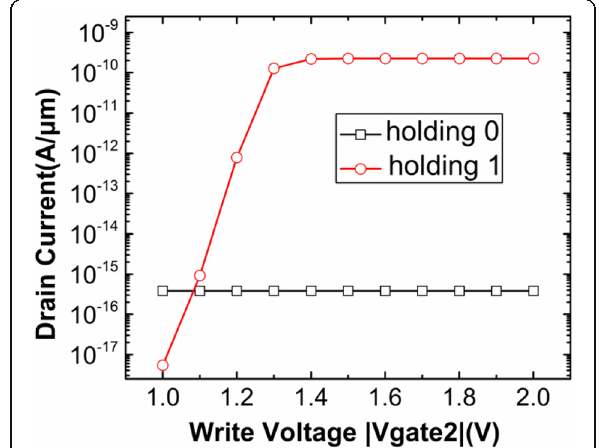
Fig. 3 Drain current of DG-TFET after holding “ 0 ” and holding “ 1 ” . This figure shows the variation of drain current after holding “ 0 ” and holding “ 1 ” with respect to writing